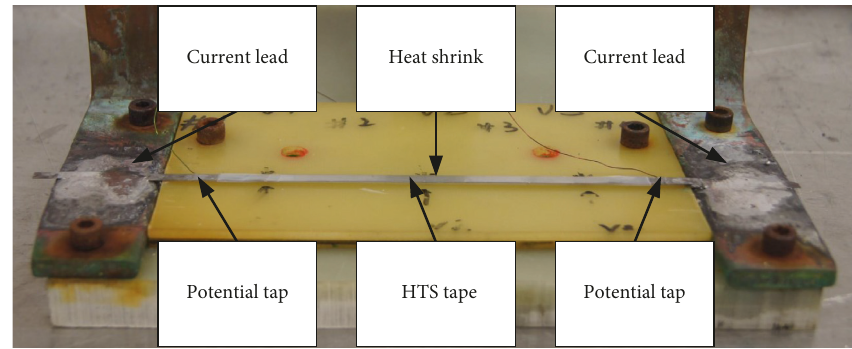
Figure 2: Experiment setup to measure critical current of the HTS